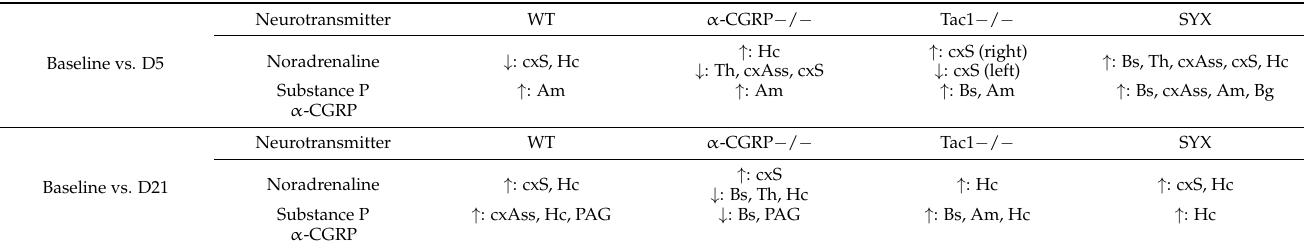
Table 2. Gene expression network correlation analysis data corresponding to Figure 6 (nociception). Data provide an overview of which neurotransmitters (of those modulated in our mouse models) are mainly expressed in the affected brain